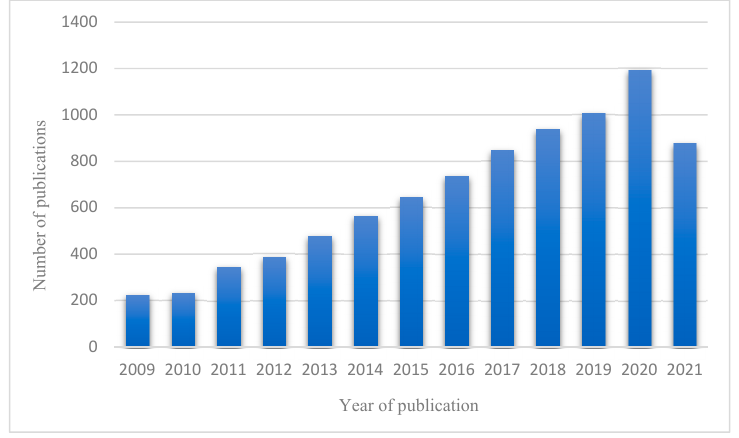
Figure 4. Statistical analysis of articles related to the topic of “bio-oil gasification”.